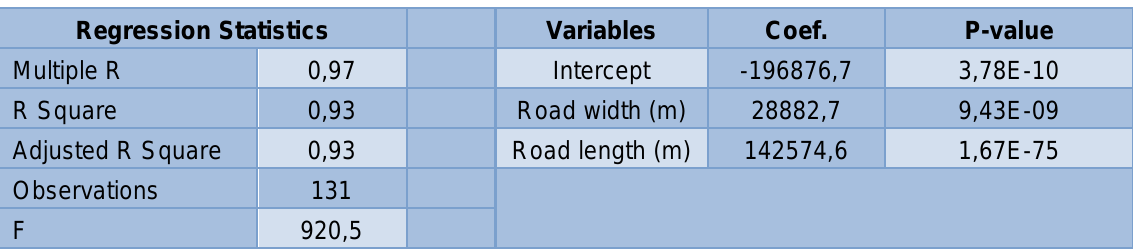
Table 13 Multiple regression results among total project cost and road length and